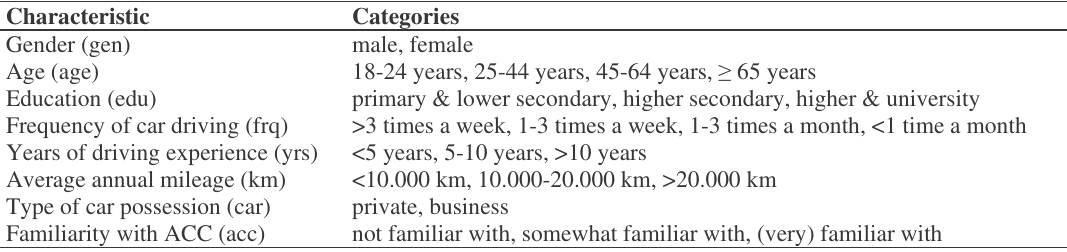
Table 5. Driver characteristics and categories on behalf of statistical tests Characteristic